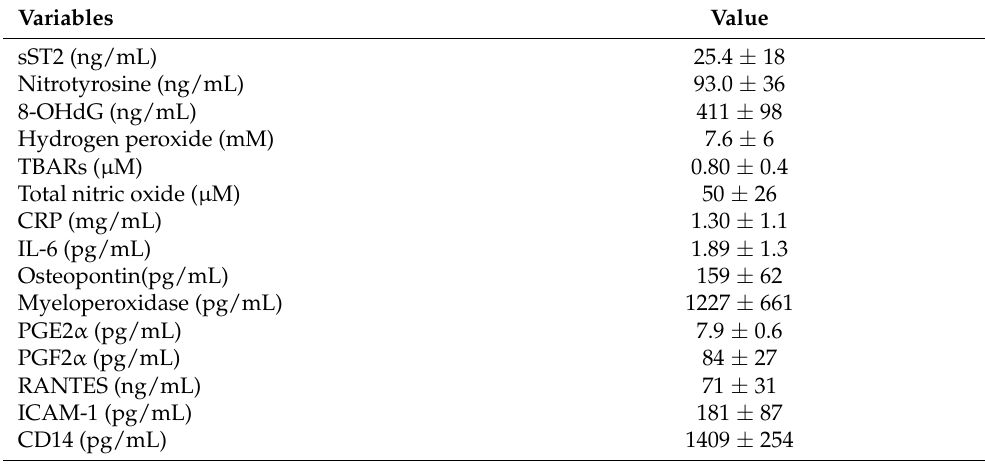
Table 4. sST2, oxidative stress markers and inflammatory molecules in the study